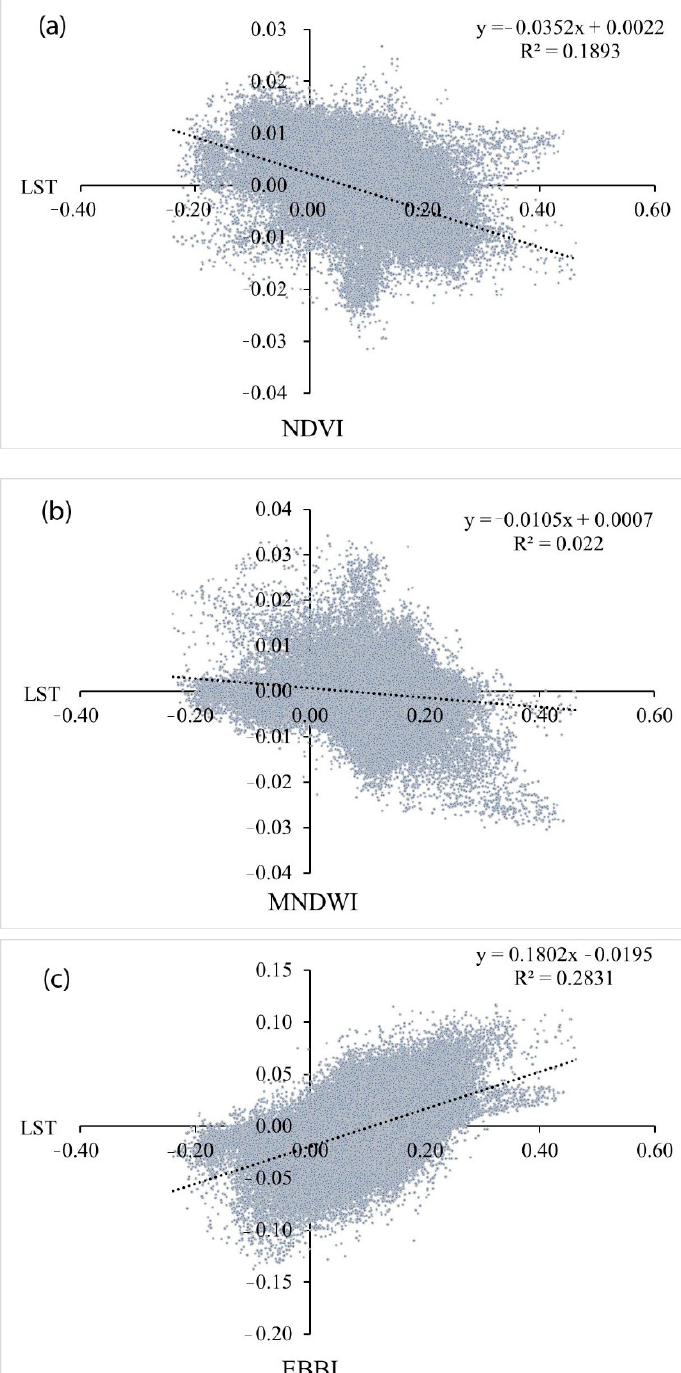
Table 7. Pearson correlation between the annual rate of change in the LST and the annual rate of change in the NDVI, MNDWI and EBBI indices (1987–2019). NDVI MNDWI